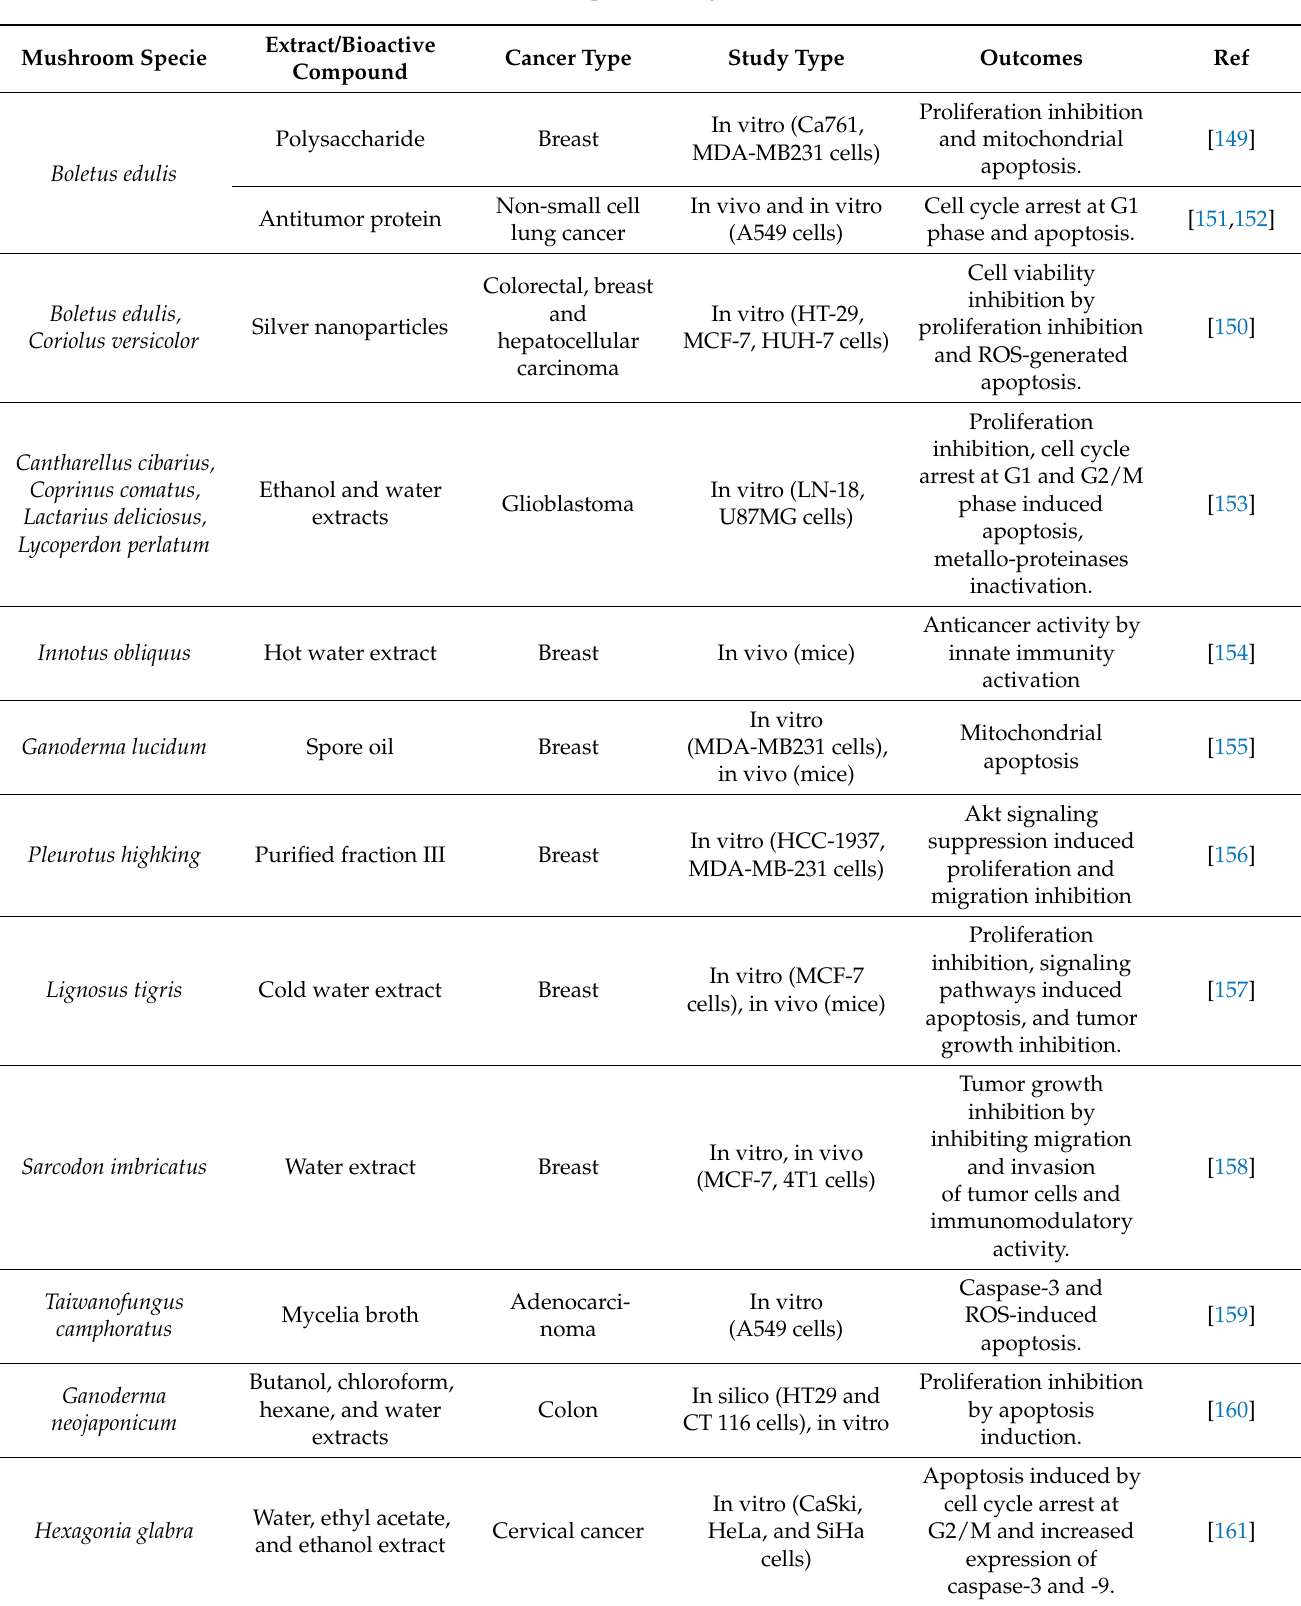
Table 2. Some mushroom species, along with their anti-tumor